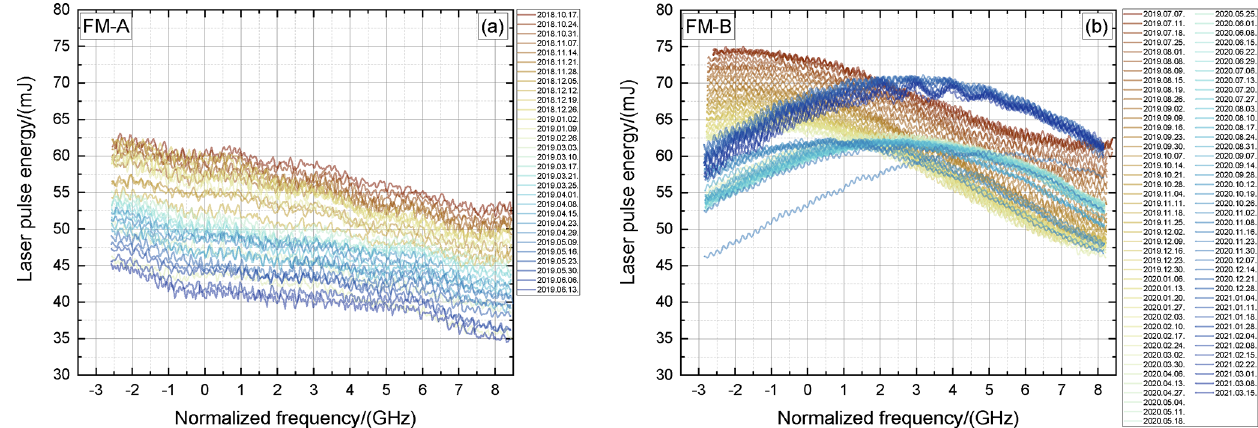
Figure 2. Mean laser pulse energy versus normalized laser frequency derived from ISR measurements for the FM-A period (a) and FM-B period (b) .